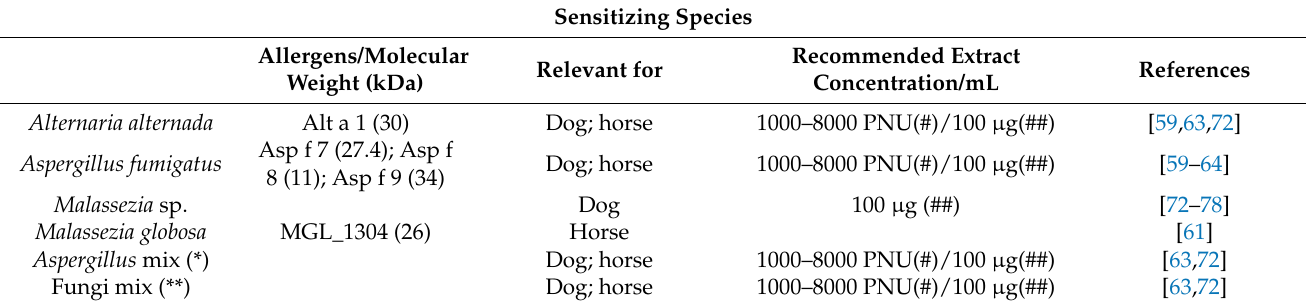
Table 1. Summary of the current, most relevant information on the sensitization and allergy to fungi in veterinary